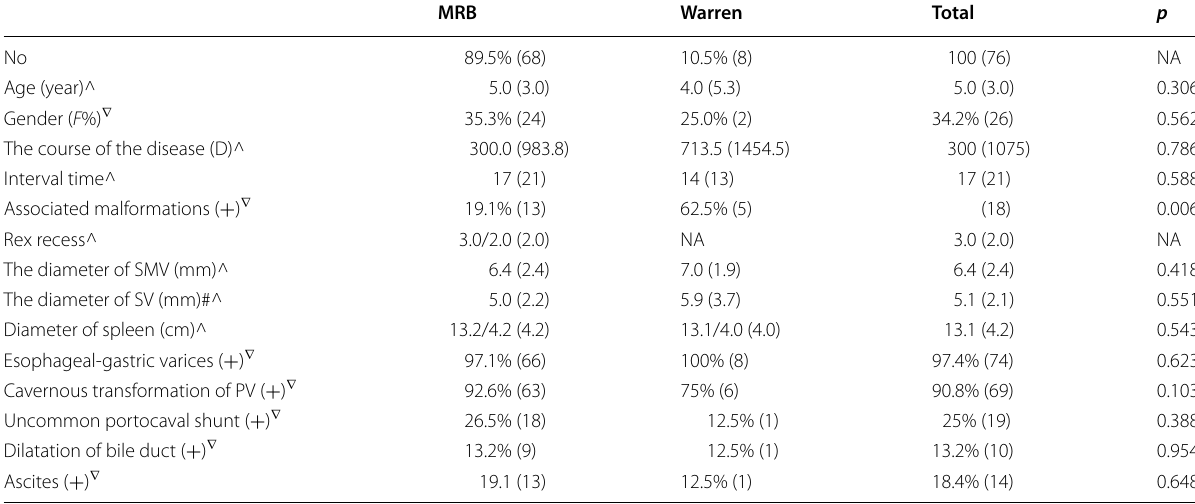
Table 1 Clinical data and imaging features of 76 children with